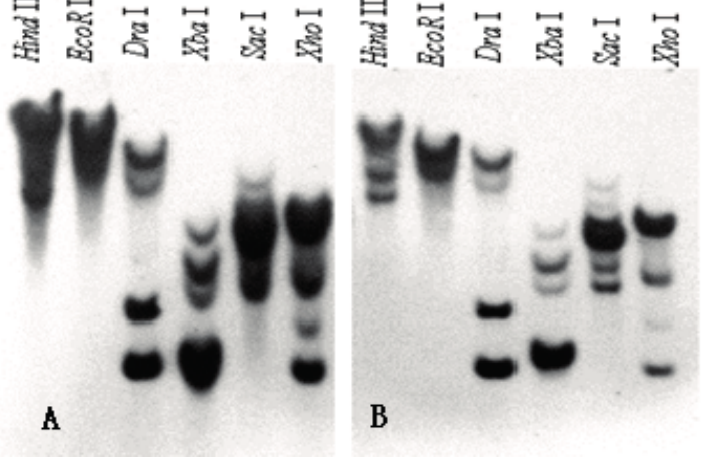
Figure 3. Southern analysis of Skp1-like genes in ( A ) “Wuzishatangju” and ( B ) “Shatangju”